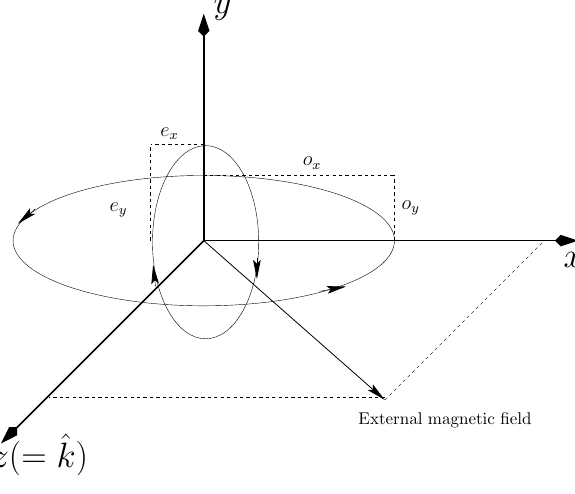
Fig. 1. The coordinate system and a general polarization ellipse. The orientation angle is represented by ψ , a represents the semi- major axis, b represents the semi-minor axis, and θ is the aspect angle. The propagation direction of the wave ˆ k is in the z -direction and the polarization of interest is in the x-y-plane.